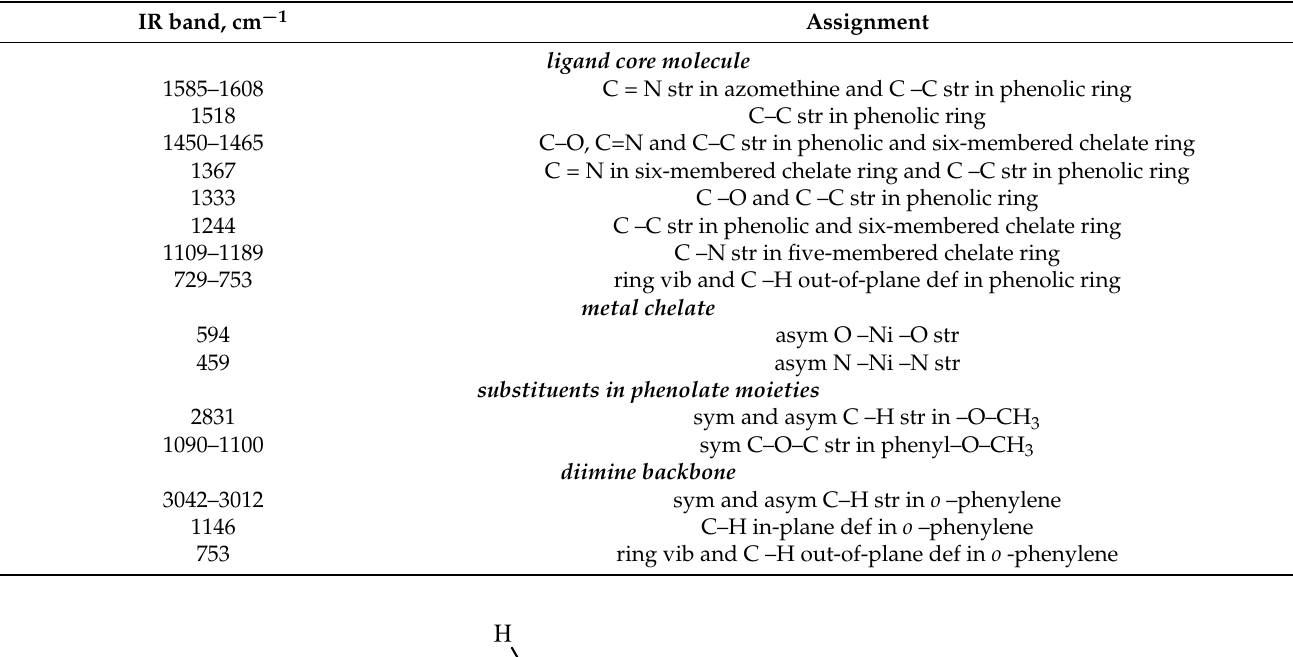
Table 2. IR band assignment according to [20].